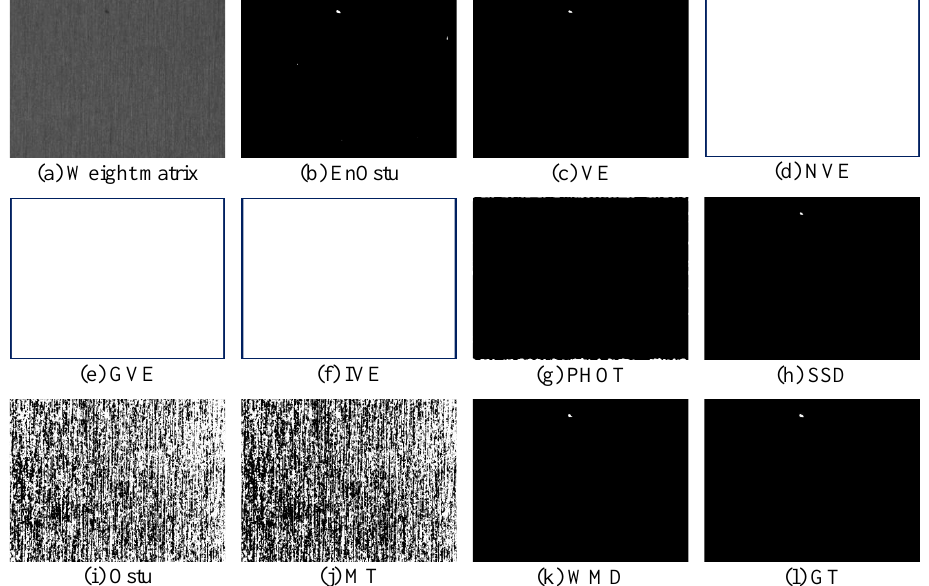
Figure 13. Visual comparisons of detection results using the ten methods on weighed matrix. NVE, GVE, IVE, and PHOT do not have any output. EnOstu, VE, SSD, Ostu, MT, and our method (WMD) have the ability to separate defects from the background.